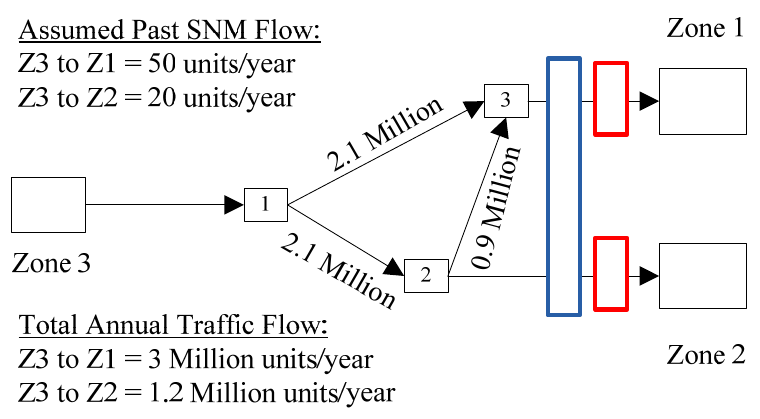
Figure 3. Example case to explain mobile sensor